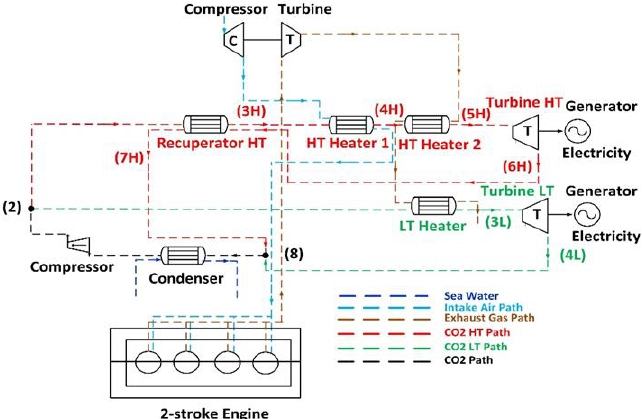
Figure 6. Schematic view of the cascade supercritical CO 2 cycle.